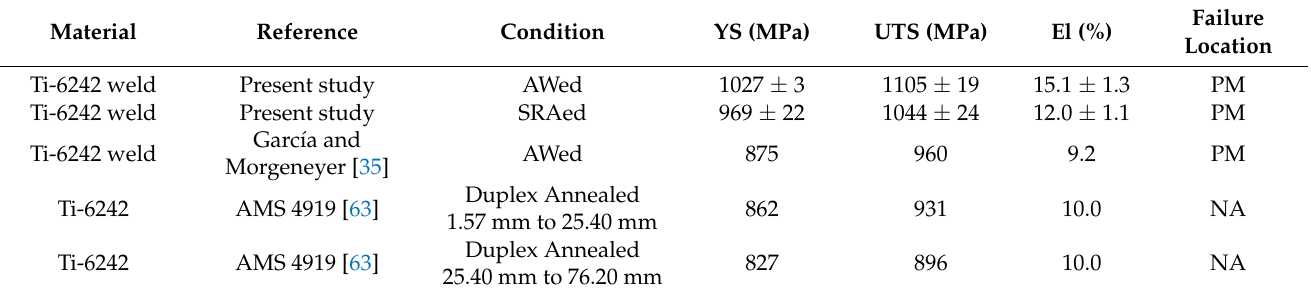
Figure 10. Average tensile stress-strain behavior of the Ti-6242 welds in the AWed and SRAed conditions. Table 4. Comparison of the average tensile mechanical